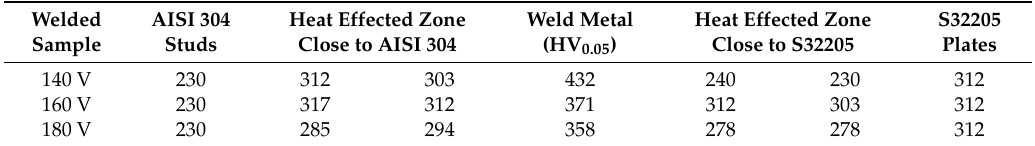
Table 4. Micro-Vickers hardness of 140 V, 160 V, 180 V welded samples.